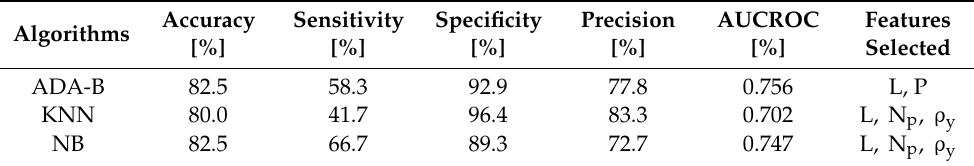
Table 4. Evaluation metrics and features included per each